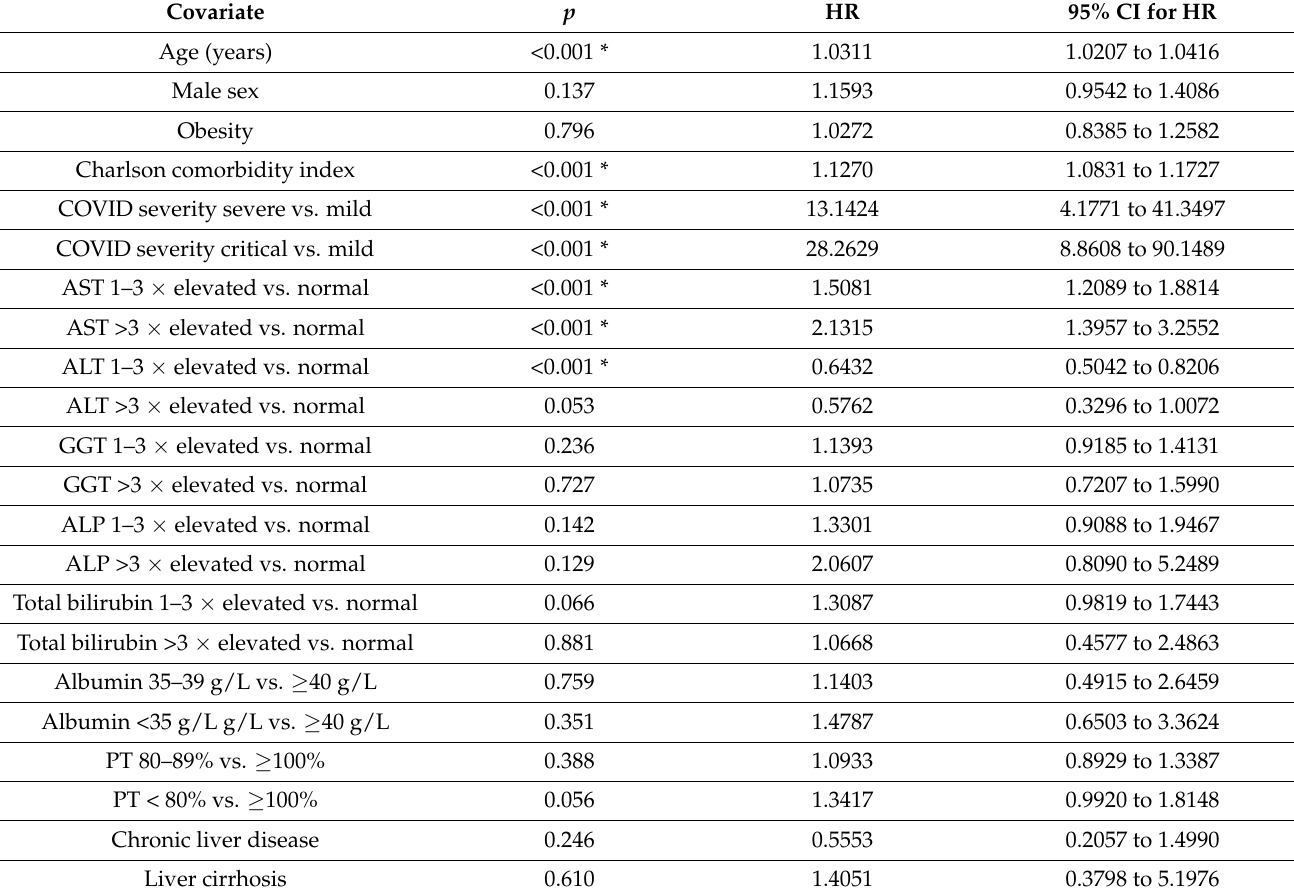
Table 4. Cox regression model investigating independent contribution of investigated parameters to 30-day mortality.